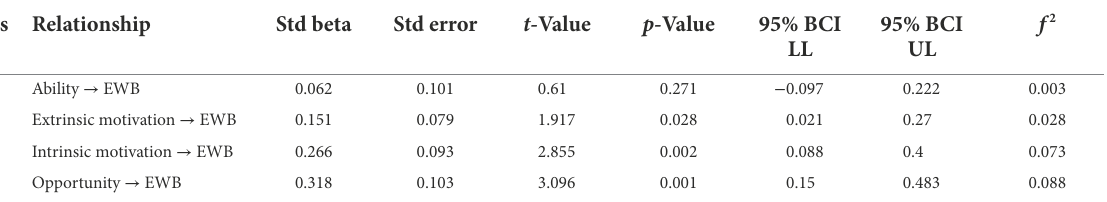
TABLE 6 Hypotheses testing.